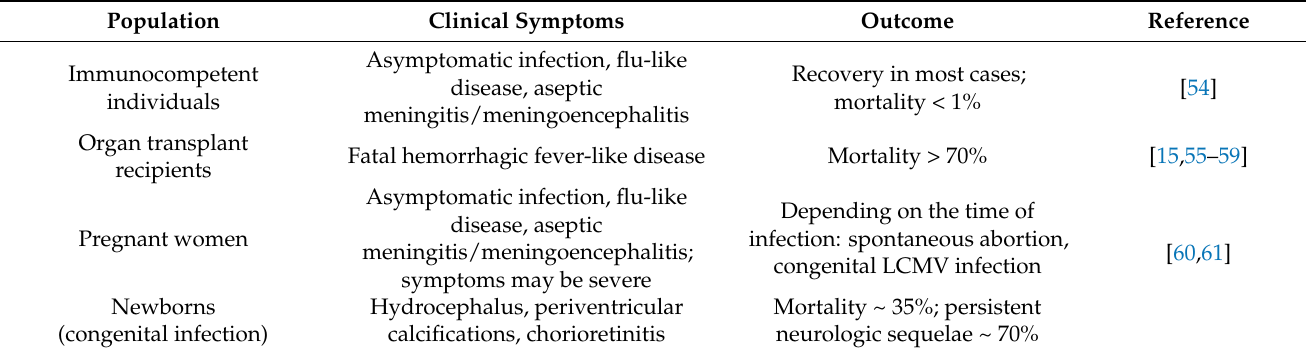
Table 1. Clinical symptoms of LCMV